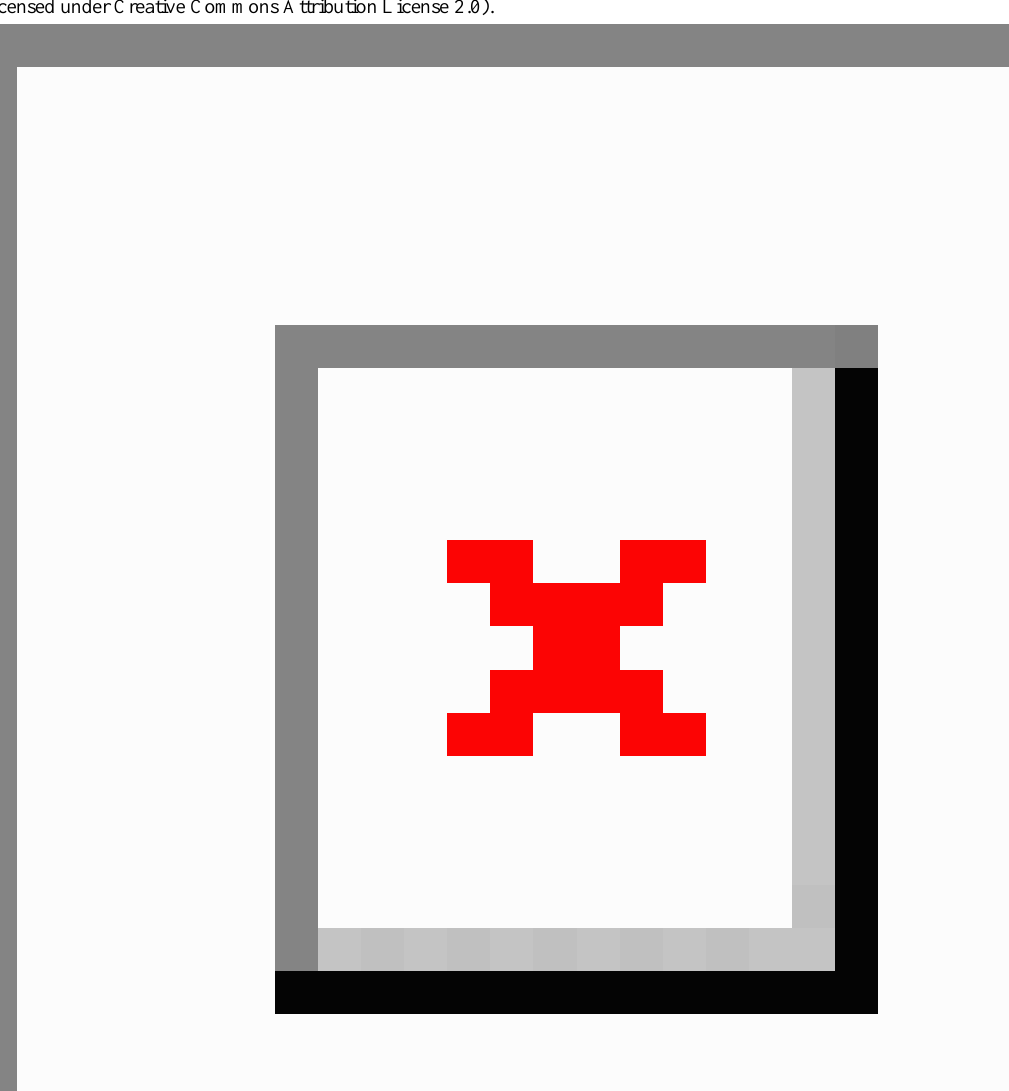
Figure 1. Charts comprising the personal profile of a user on PatientsLikeMe (Image Source: Frost & Massagli, Journal of Medical Internet